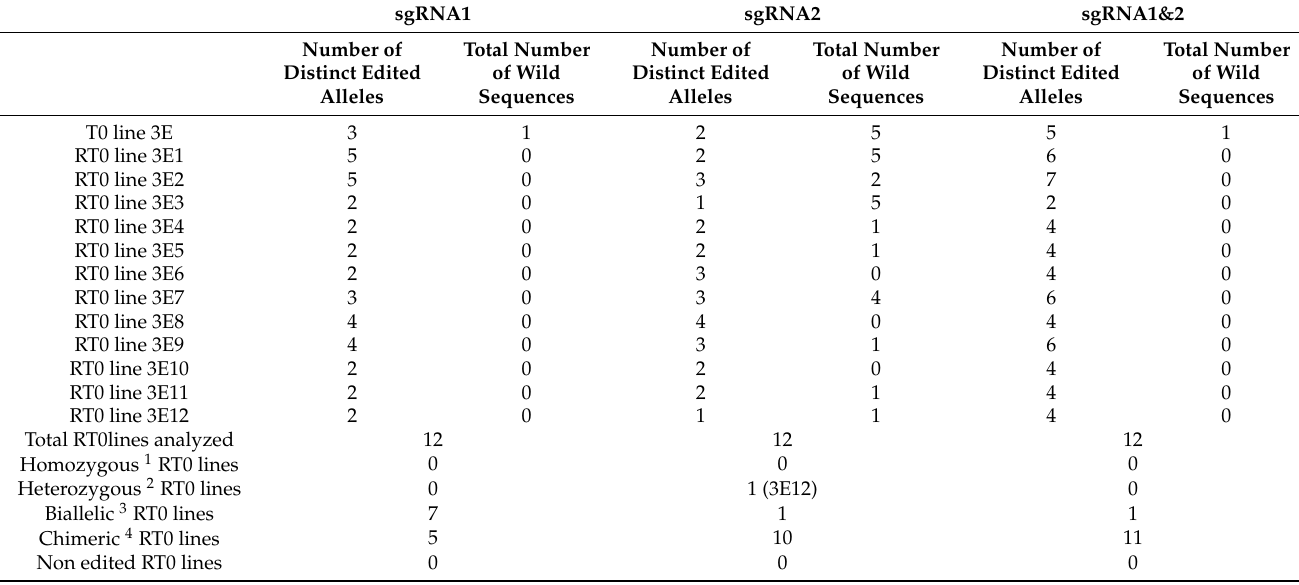
Table 1. Summary of editing profiles of T0 and RT0 transgenic lines for dechimerization assays. The numbers indicate the number of distinct edited alleles versus the total number of wild-type alleles found after the sequencing of 8–10 bacterial clones.